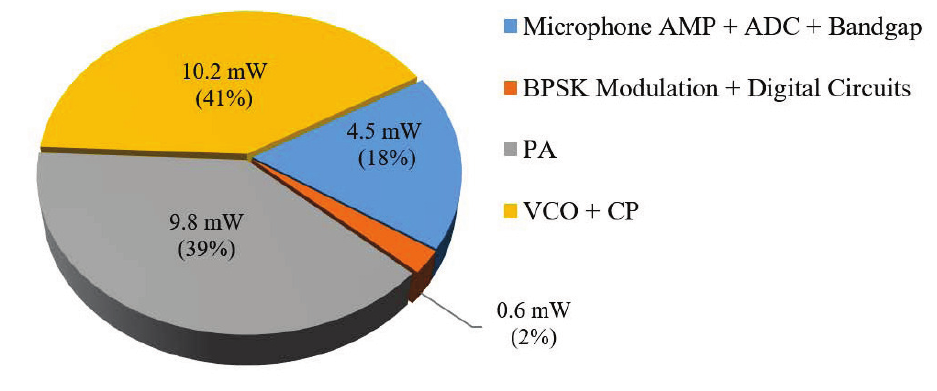
Figure 15. Measured power